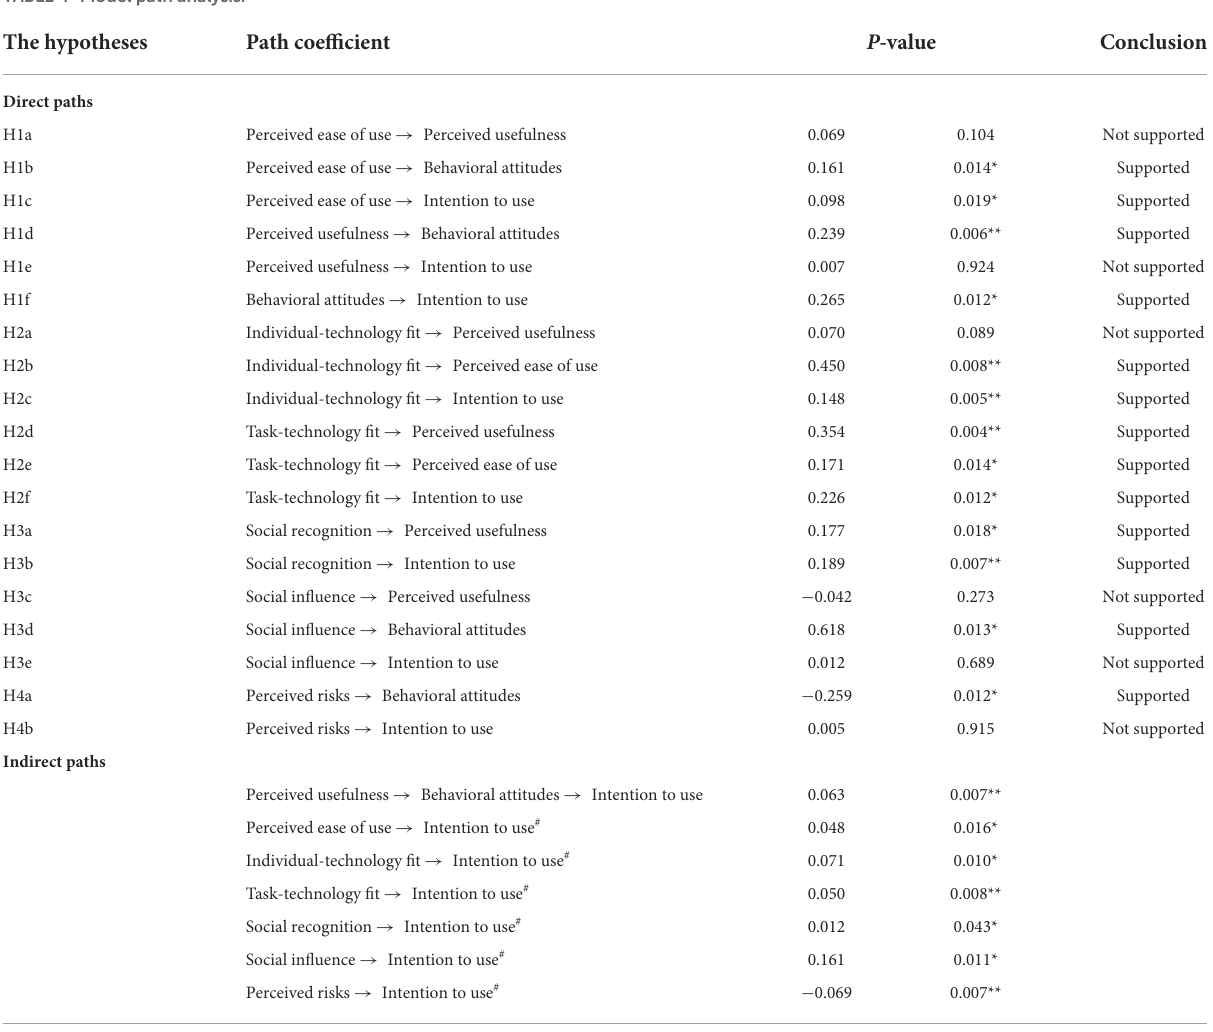
TABLE 4 Model path